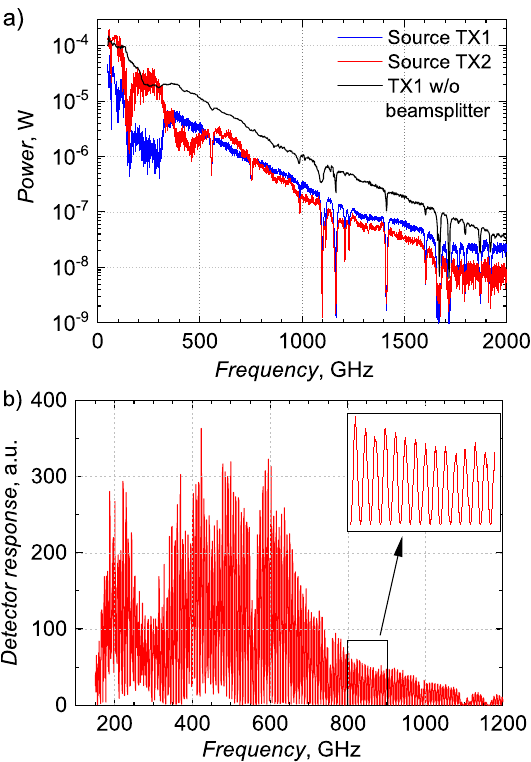
Figure 3. ( a ) Power of the THz sources in the homodyne experiment setup (marked as TX1, blue line, and TX2, red line). The measurement was provided using the same TerFET detector at the gate voltage of 475 mV. The reference measurement of the original Toptica system’s power with only one source TX1 is also presented for comparison purposes (black line). It was recorded with the pyroelectric detector. ( b ) Measured homodyne signal of TeraFET, which was biased at the same gate voltage. The magnification shows